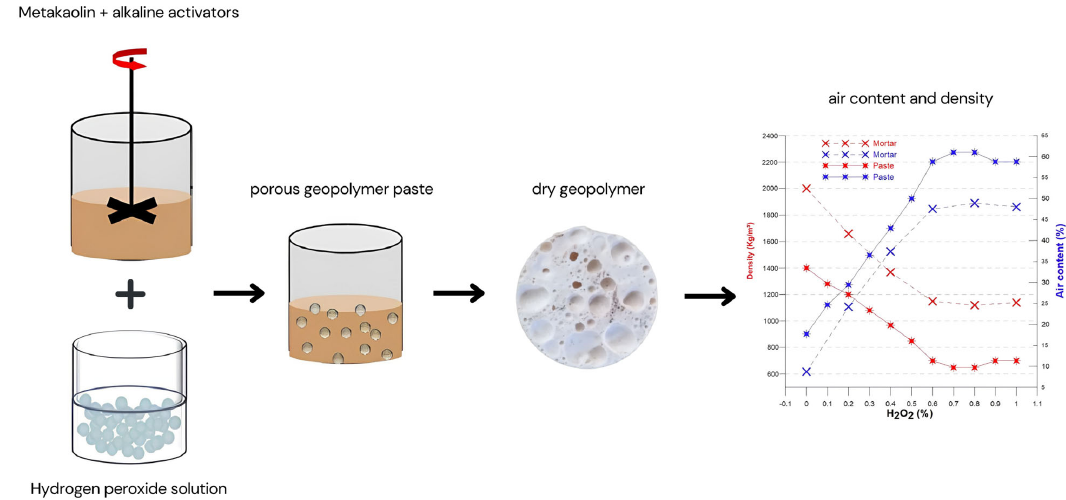
Figure 1. Graphic summary.